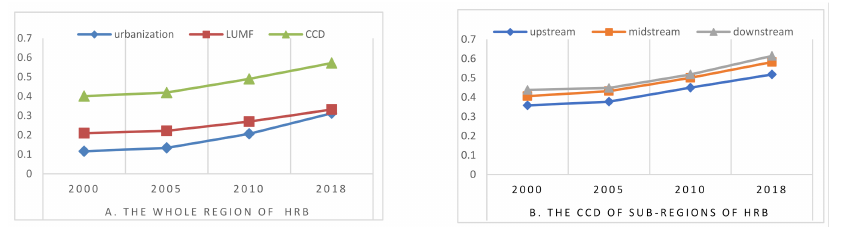
Figure 4. Temporal change trend of the coupling coordination degree between urbanization and LUMF in different regions. ( A ) represents the whole region of the HRB; ( B ) represents the three sub-regions of the HRB.